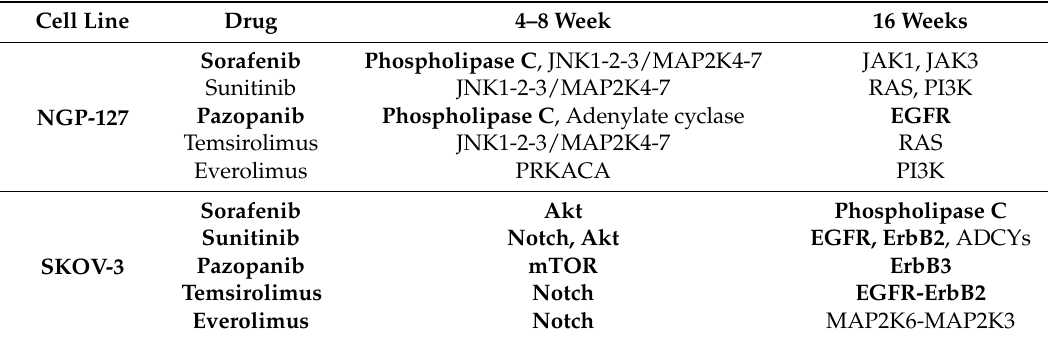
Table 1. Target proteins potentially linked with acquisition of drug resistance at different timepoints. The experimentally investigated combinations are shown in bold.